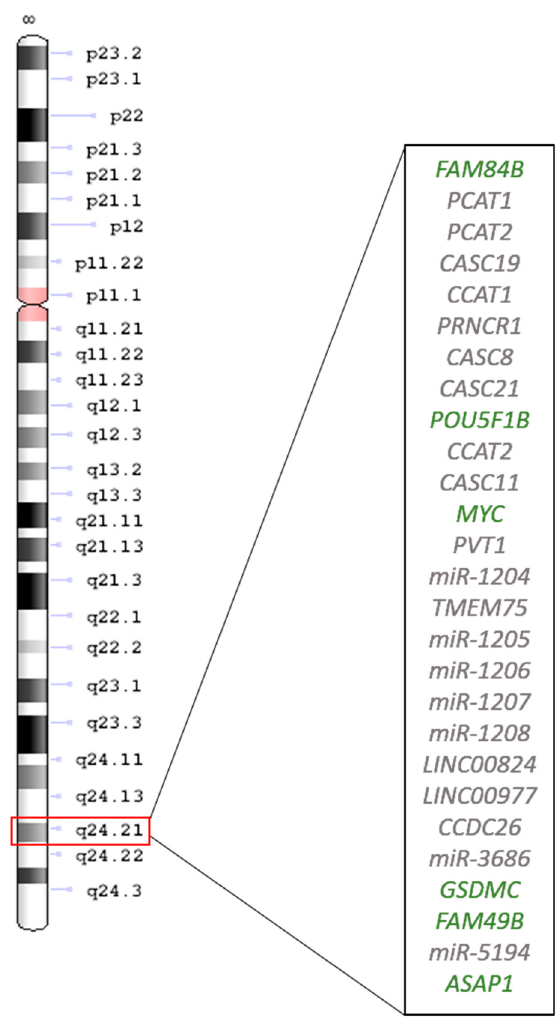
Figure 1. The 8q24.21 genes. The coding genes are shown in green, and the non-coding genes in grey. It is worth mentioning other coding and noncoding genes of 8q24.21, shown in Table 1. Among them, the plasmacytoma variant translocation 1 ( PVT1 ) oncogene encodes a long noncoding RNA